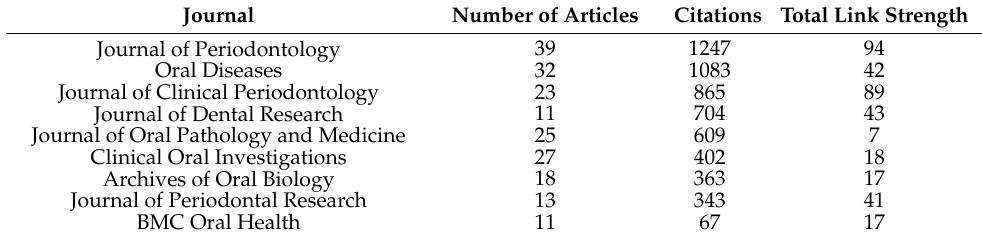
Table 2. Exhibiting the top journals that contributed to the domain of salivary biomarkers.